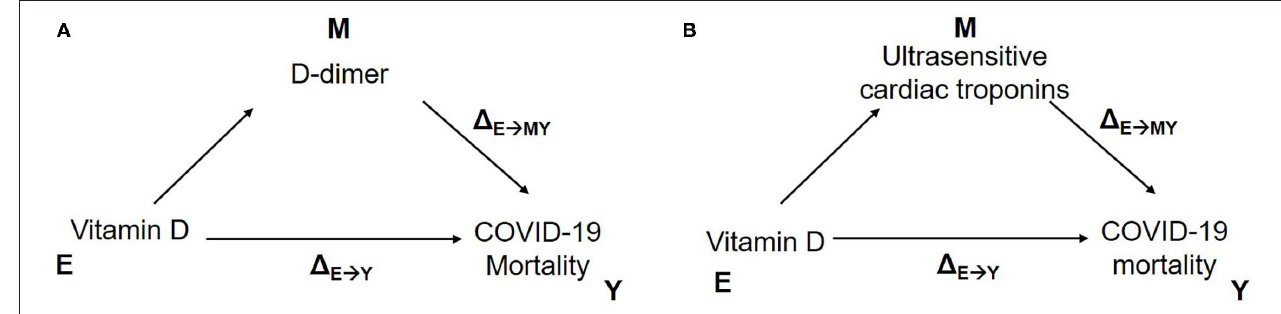
FIGURE 3 | Model-based causal mediation analyses to investigate the role of Vitamin D on COVID-19 mortality mediated by D-dimer (A) , ultrasensitive cardiac troponins (B).